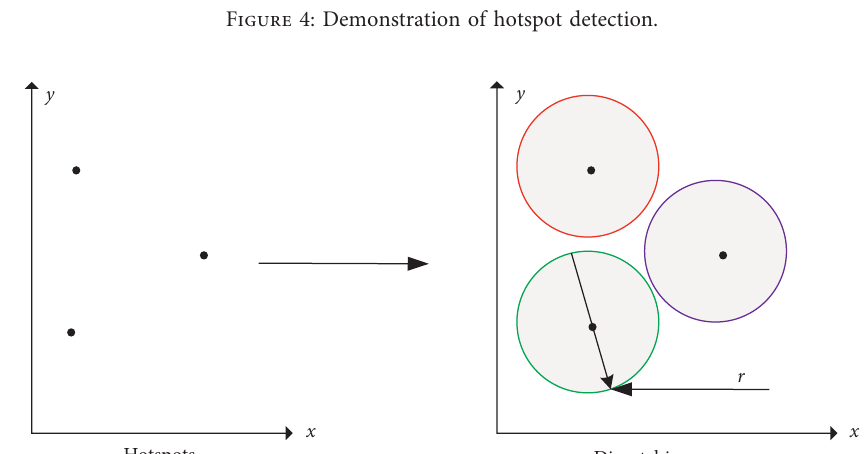
Figure 5: Establishment of dispatch area.